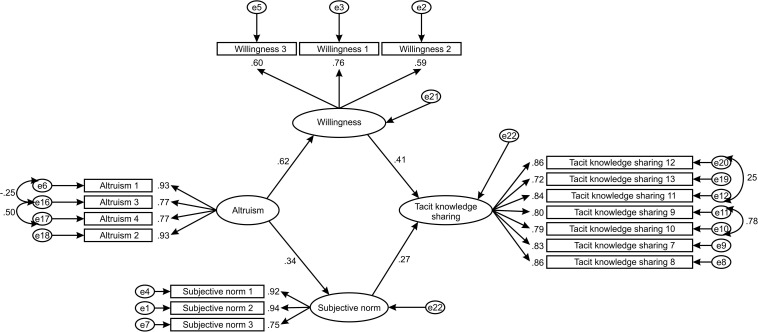
Hypothesized structural model.